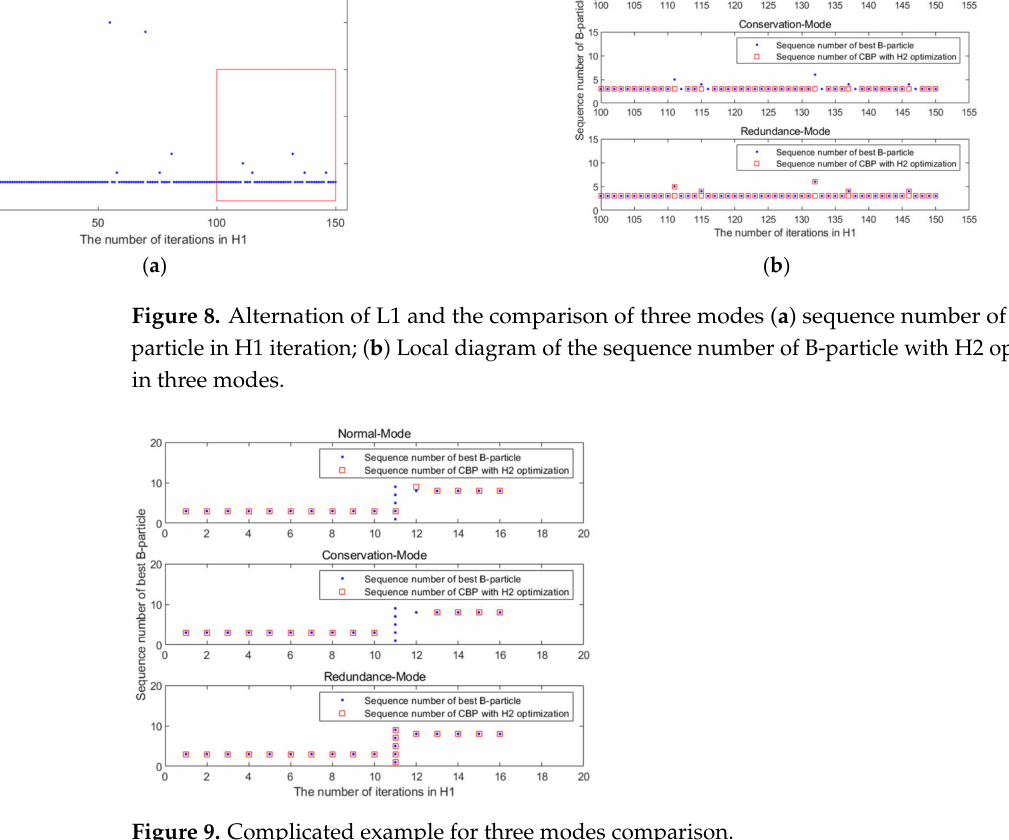
Figure 9. Complicated example for three modes comparison.